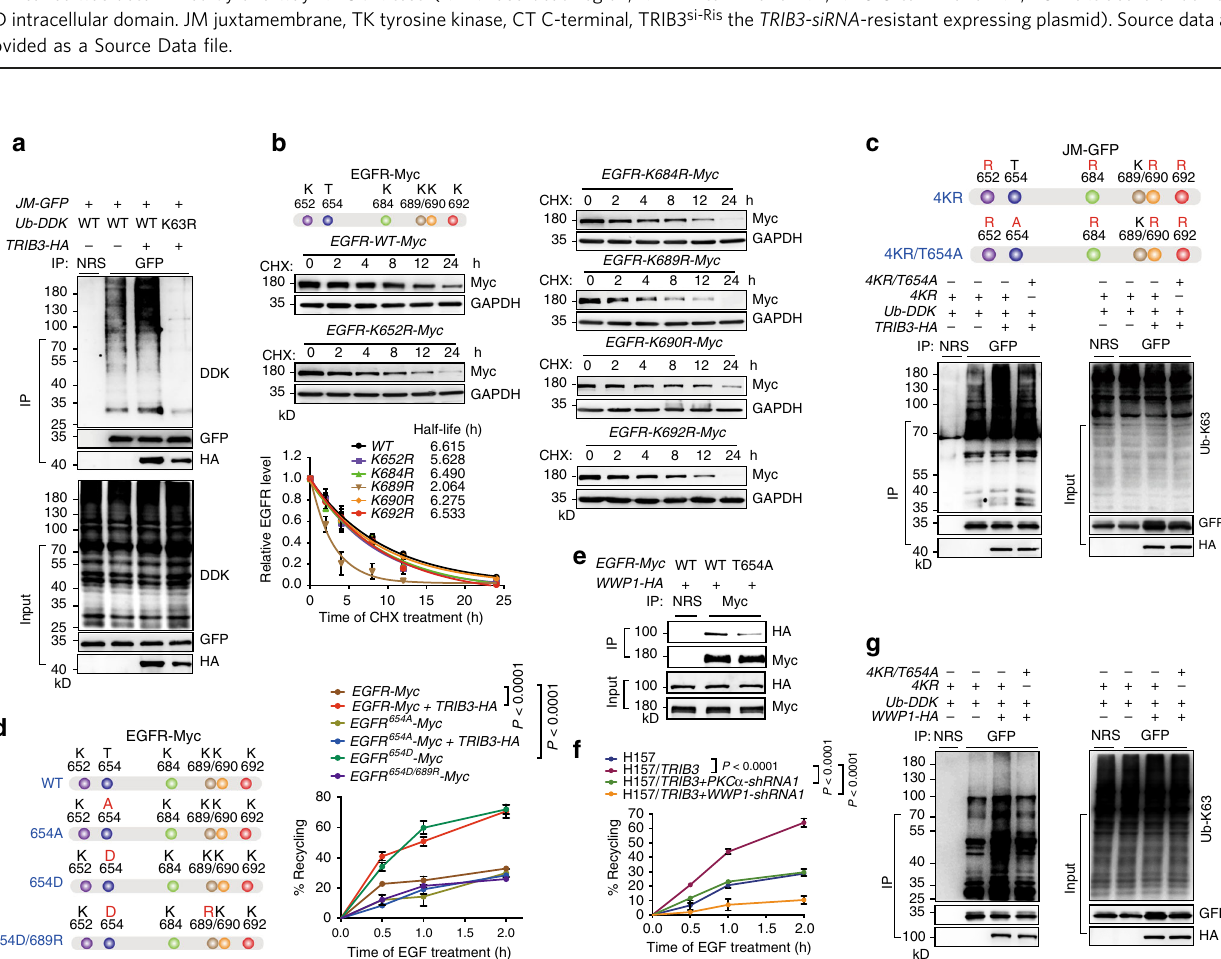
Fig. 4 WWP1-induced EGFR K689 ubiquitination is a decisive signal for EGFR recycling. a Cell extracts from HEK 293T cells transfected with indicated plasmids were IP with anti-GFP Ab. The ubiquitination of EGFR JM region was detected by IB. b Mapping the lysine sites responsible for EGFR stability in EGFR JM region. HEK 293T cells transfected with indicated plasmids were incubated with CHX (10 μ g ml − 1 ) at indicated intervals and expression of indicated proteins were analyzed by IB. c The K63-linked ubiquitination of the indicated JM mutants were analyzed by IB in HEK 293T cells transfected with indicated plasmids. d The recycling of indicated EGFR mutants was detected in HEK 293T cells transfected with indicated plasmids. e Cell extracts from HEK 293T cells transfected with indicated plasmids were IP with anti-Myc Ab. The binding of WWP1 with EGFR wild type and EGFR T654A mutant were detected by IB. f EGFR recycling was determined by ELISA in indicated NCI-H157 cells. g The K63-linked ubiquitination of the indicated JM mutants were analyzed by IB in HEK 293T cells transfected with indicated plasmids. For a, c , e , and g , data are representatives of three independent assays. For b , d , and f , data indicate means ± SEM, n = 3. Statistical signi fi cance among groups was determined by one-way ANOVA test. Source data are provided as a Source Data fi